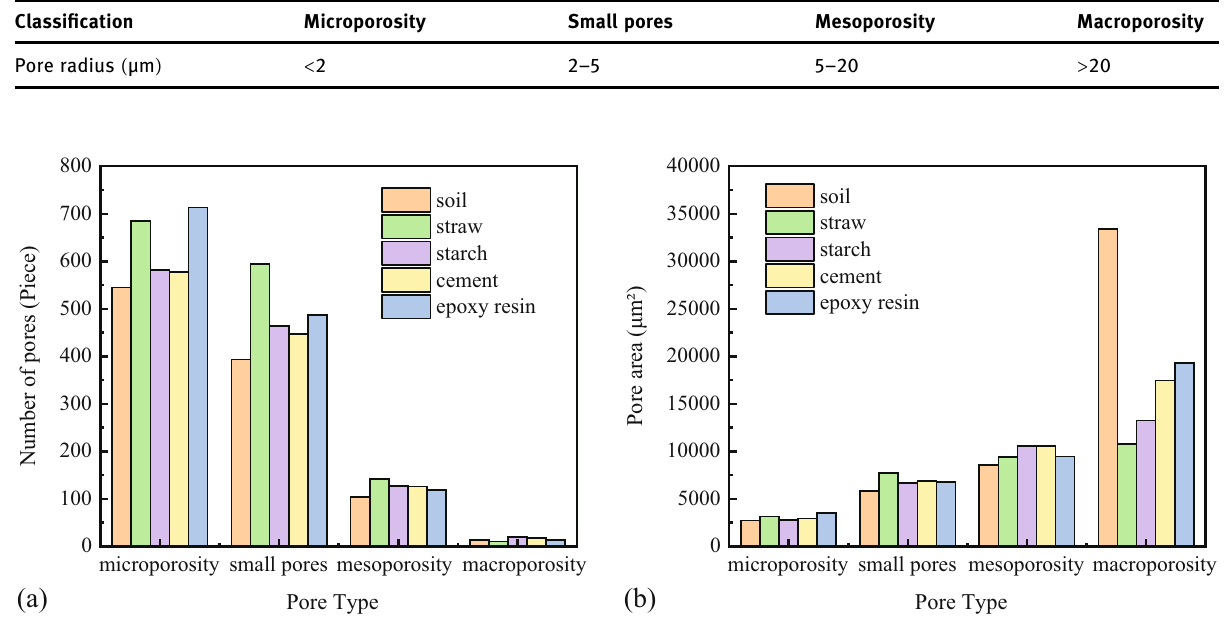
Figure 22: Pore area distribution of di ff erent materials: ( a ) pore number distribution and ( b ) pore area distribution.